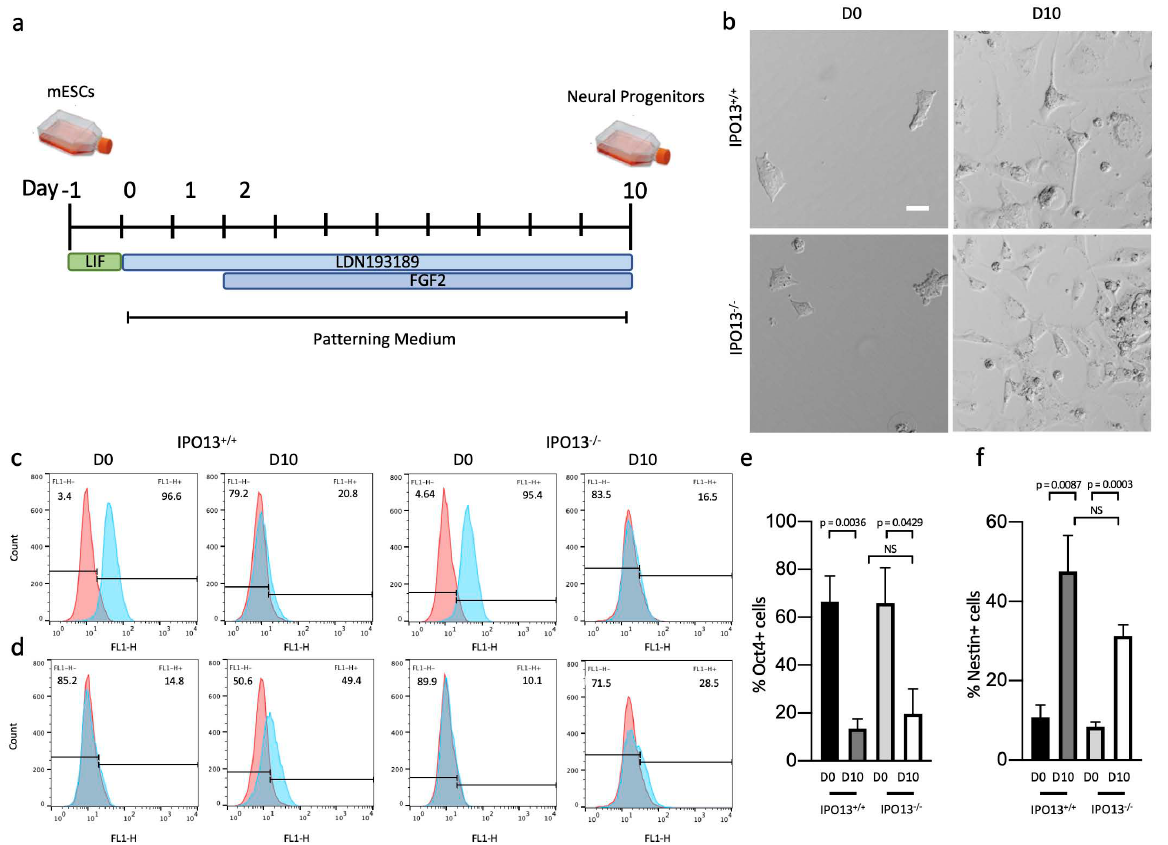
Figure 1. IPO13 +/+ and IPO13 − / − mESCs differentiate into neural progenitor cells by D10. IPO13 +/+ and IPO13 − / − mESCs were induced to differentiate toward a dorsal forebrain fate using a monolayer- based differentiation protocol and patterning medium supplemented with LDN193189 and FGF2 ( a , b ). Representative images of IPO13 +/+ and IPO13 − / − mESCs imaged live at D0 and D10 post differentiations using phase contrast. ( c – f ). Flow cytometry analysis of Oct4 and Nestin in IPO13 +/+ and IPO13 − / − mESCs at differentiation D0 and D10. ( c , d ). Representative histograms of Oct4 ( c ) and Nestin ( d ) stained cell populations (blue) and FITC alone control (red). ( e , f ). Pooled data mean ± SEM ( n = 4) for % Oct4 ( e ) or Nestin ( f ) positive cells from analysis, such as that in ( c , d ). p values (2-tailed Student’s t -test) are indicated. Scale bar (10 µ